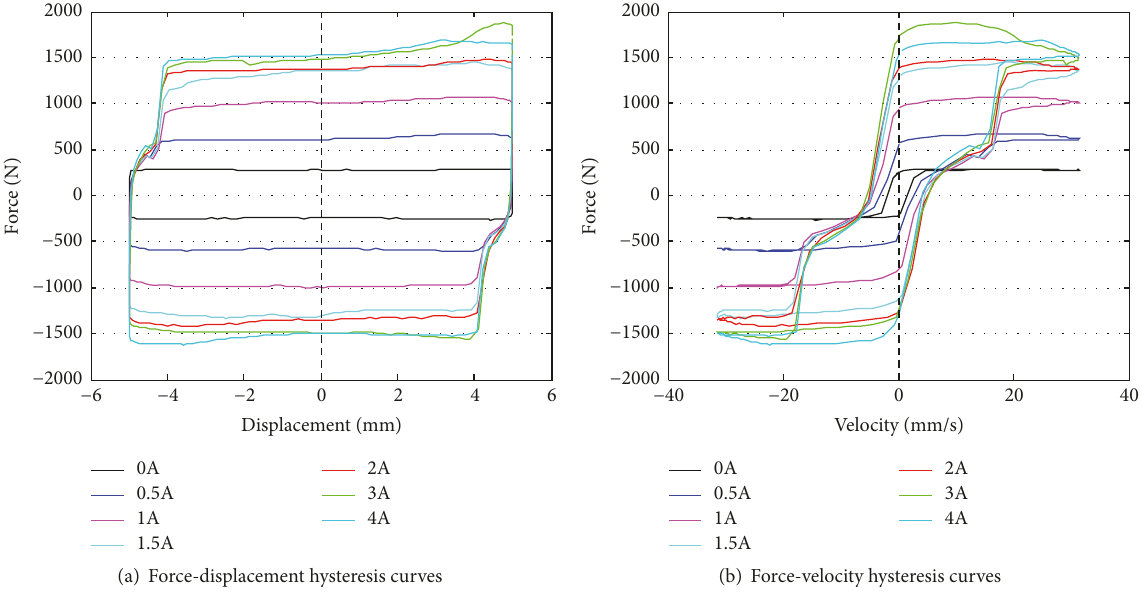
Figure 19: Hysteresis curves under different drive current at frequency of 1 Hz.